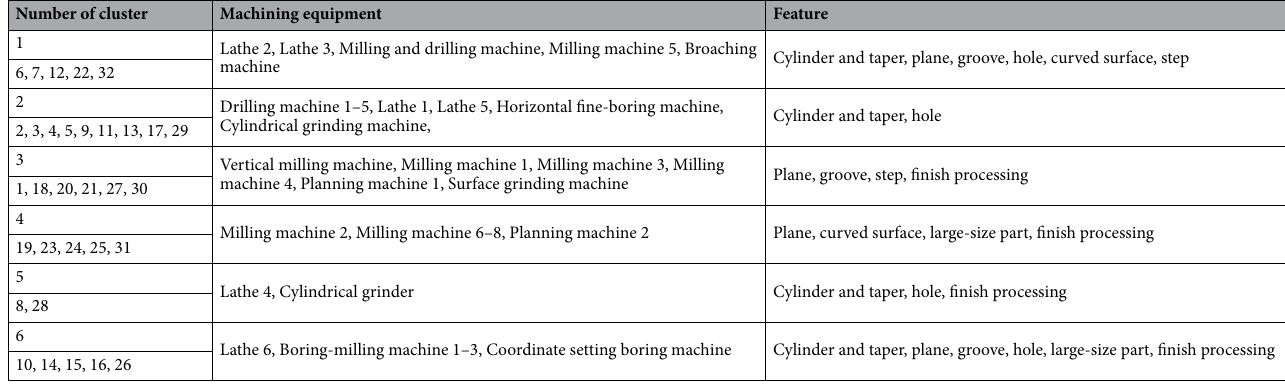
Table 2. Classification result of manufacturing